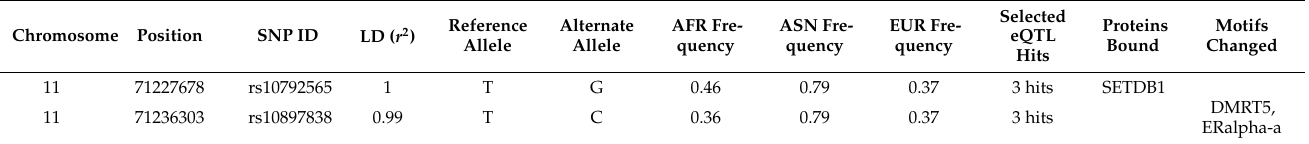
Table 3. Regulatory annotation of SHANK2 rs10792565 and its linked proxy SNPs.